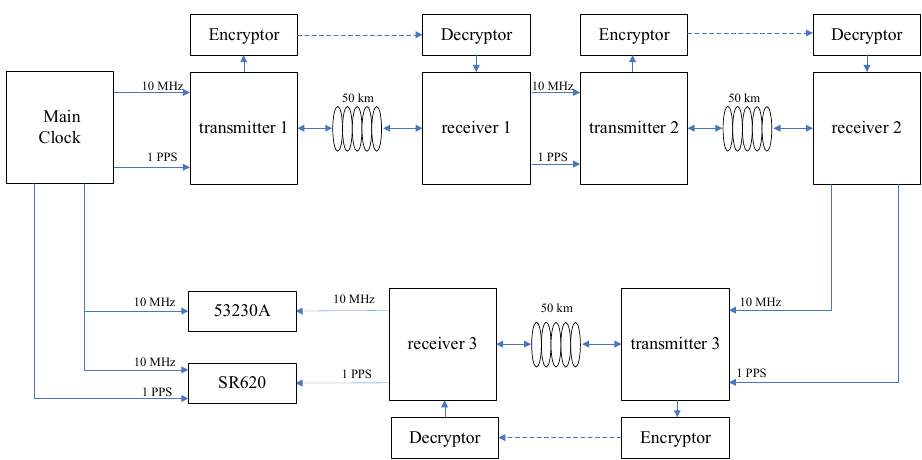
Figure 8. A ring time transfer network via a 150 km fiber optic link with three nodes.